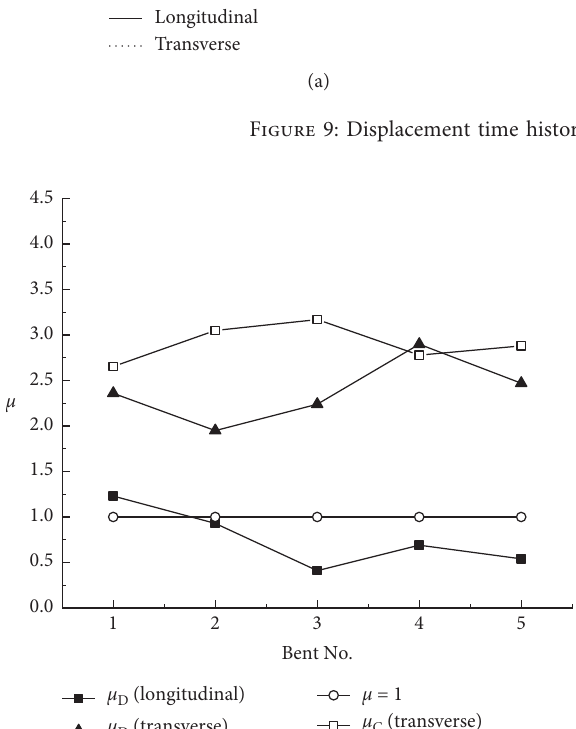
Figure 10: Ductility demands of